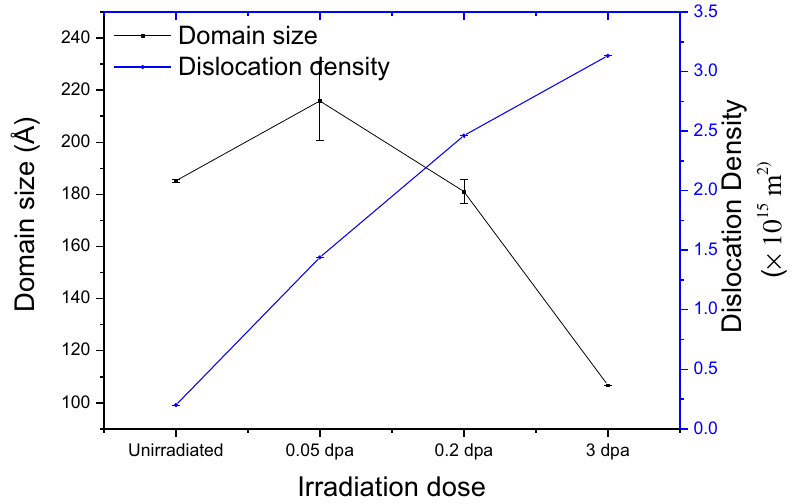
Figure 6. Variation of domain size with increase in irradiation dose on RPV steel samples irradiated at room temperature.